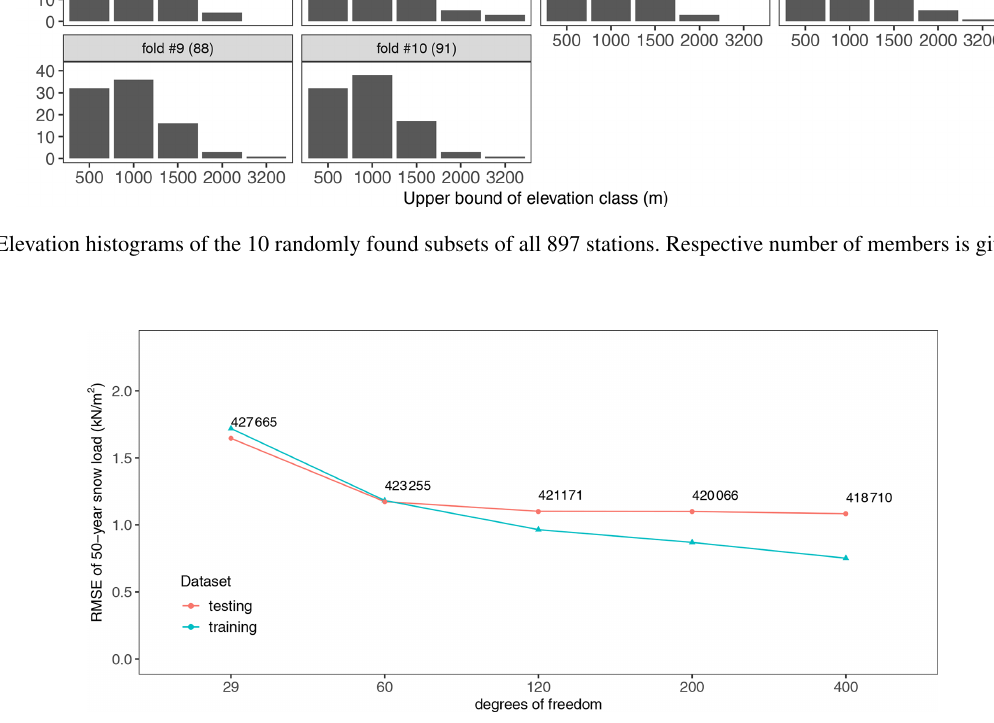
Figure A2. Lines show the RMSE based on a 10-fold cross-validation of all 897 stations for testing and training datasets for models with increasing degrees of freedom. The numbers refer to the largest AIC of the training datasets out of 10 passes for each degree of